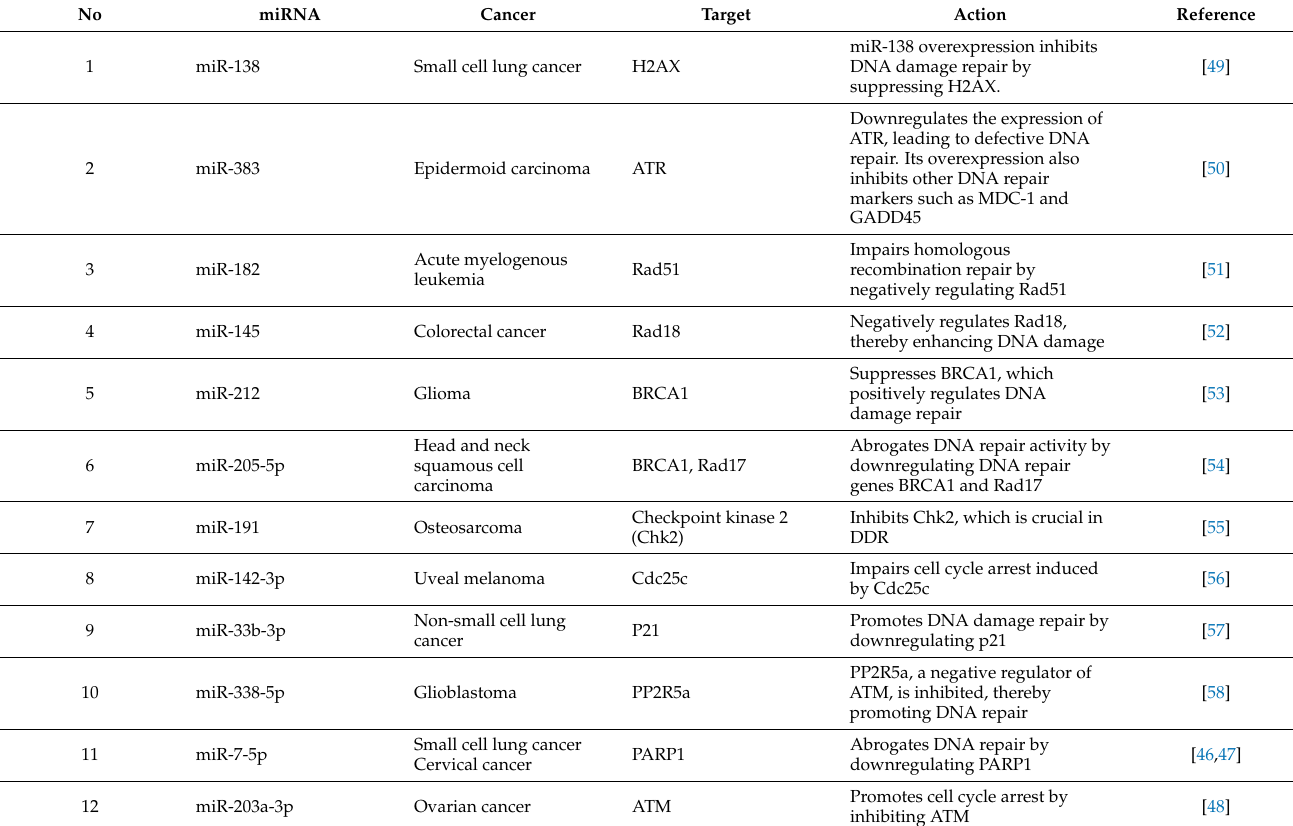
Table 2. The miRNAs implicated in DNA